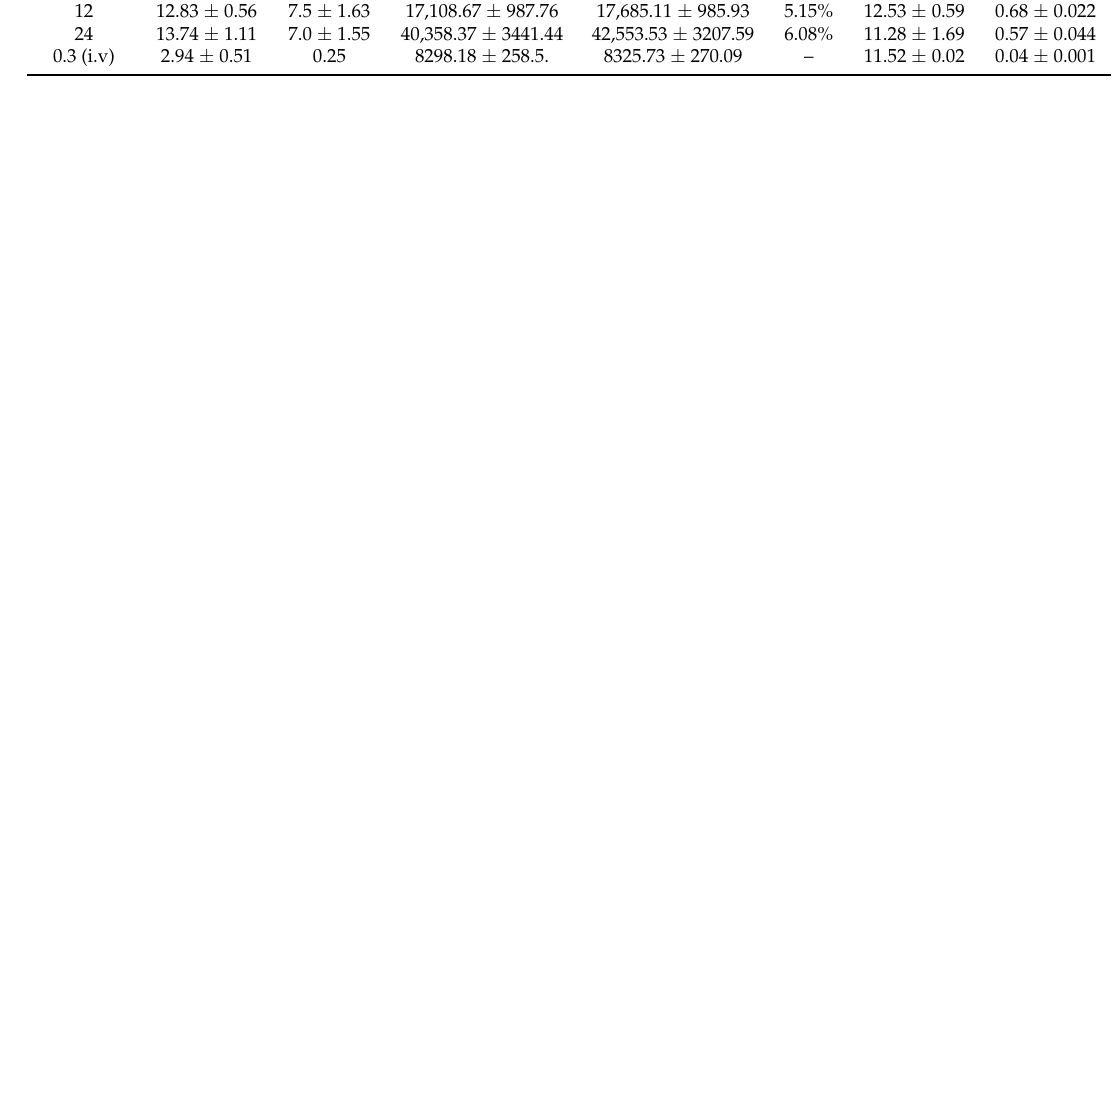
Table 4. Pharmacokinetic parameters after intragastric or intravenous administration in rats. Dose